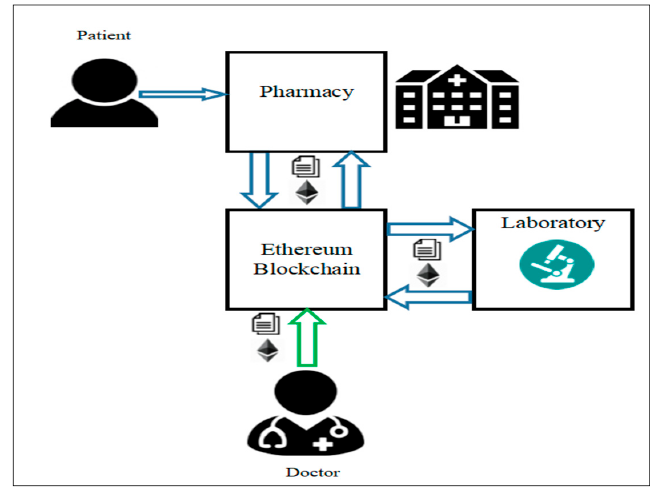
Figure 7. Smart contracts for conducting clinical trials.